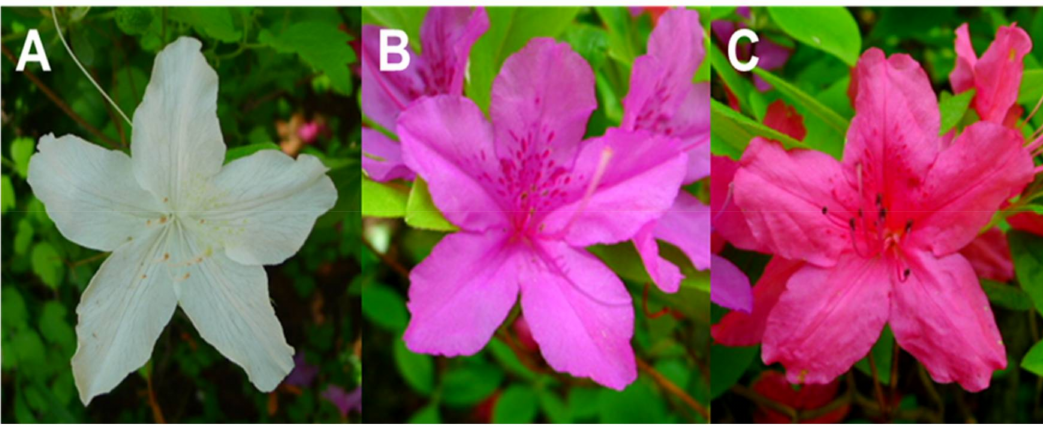
Figure 1. Three different colored flowers of Rhododendron schlippenbachii . ( A ) white, ( B ) violet, ( C )